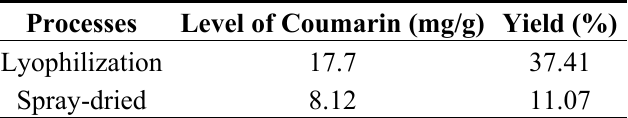
Table 3. Coumarin (2 H -1-benzopyran-2-one) levels (mg/g) analyzed by HPLC-UV method and the yield (%) found in the dried extracts processed by lyophilization and spray dried using Aerosil 8% as